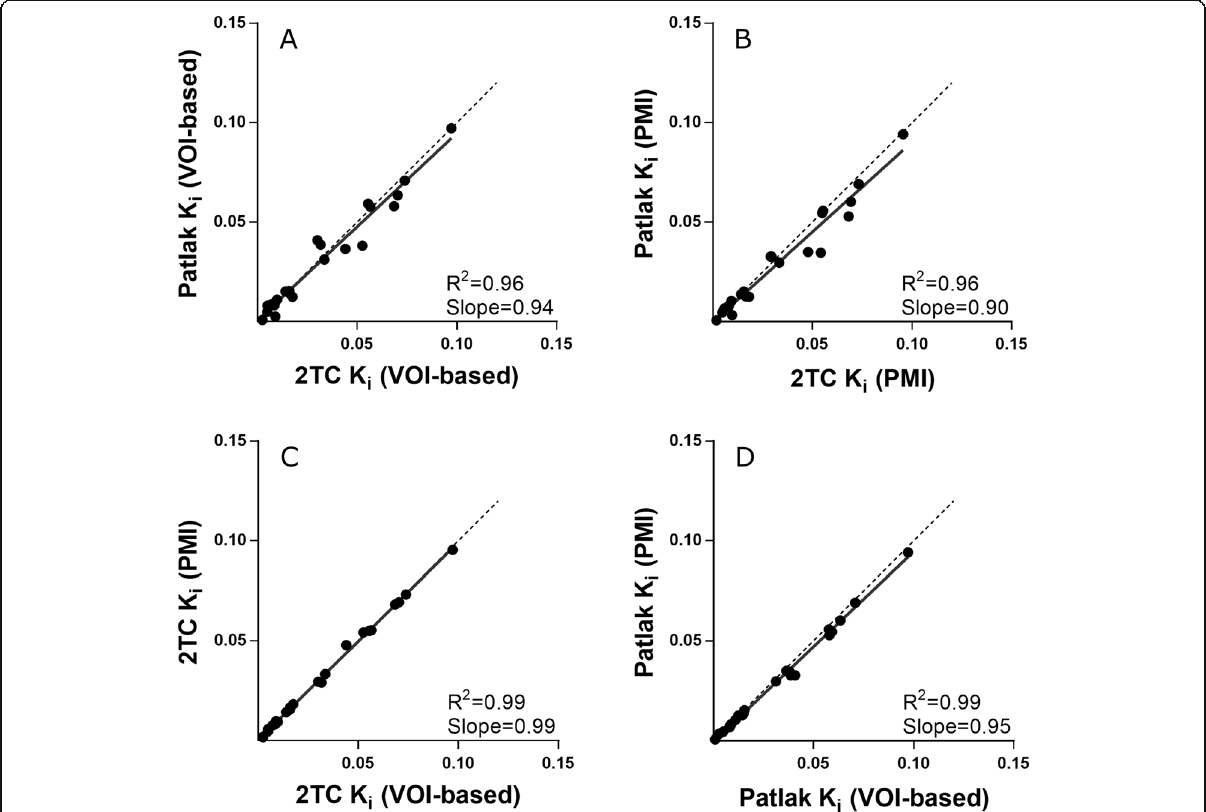
Fig. 3 Correlations between a VOI-based 2TC K i and Patlak K i , b parametric 2TC K i and Patlak K i , c VOI-based and parametric 2TC K i values, and d VOI-based and parametric Patlak K i values (PMI, parametric